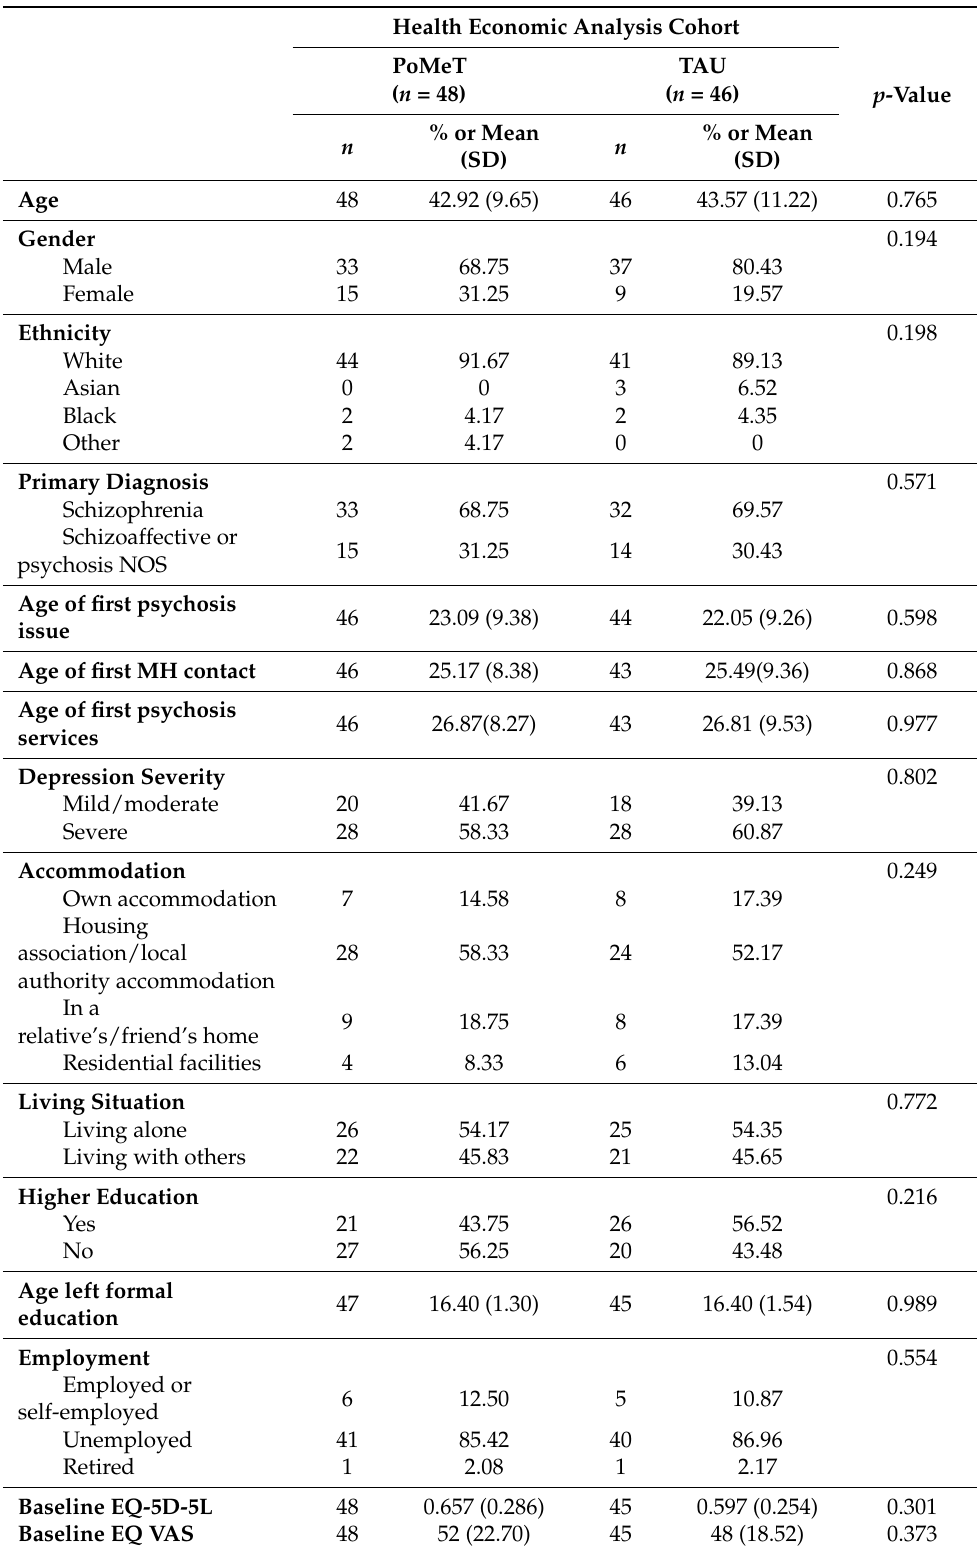
Table 1. Health economic analysis cohort characteristics at